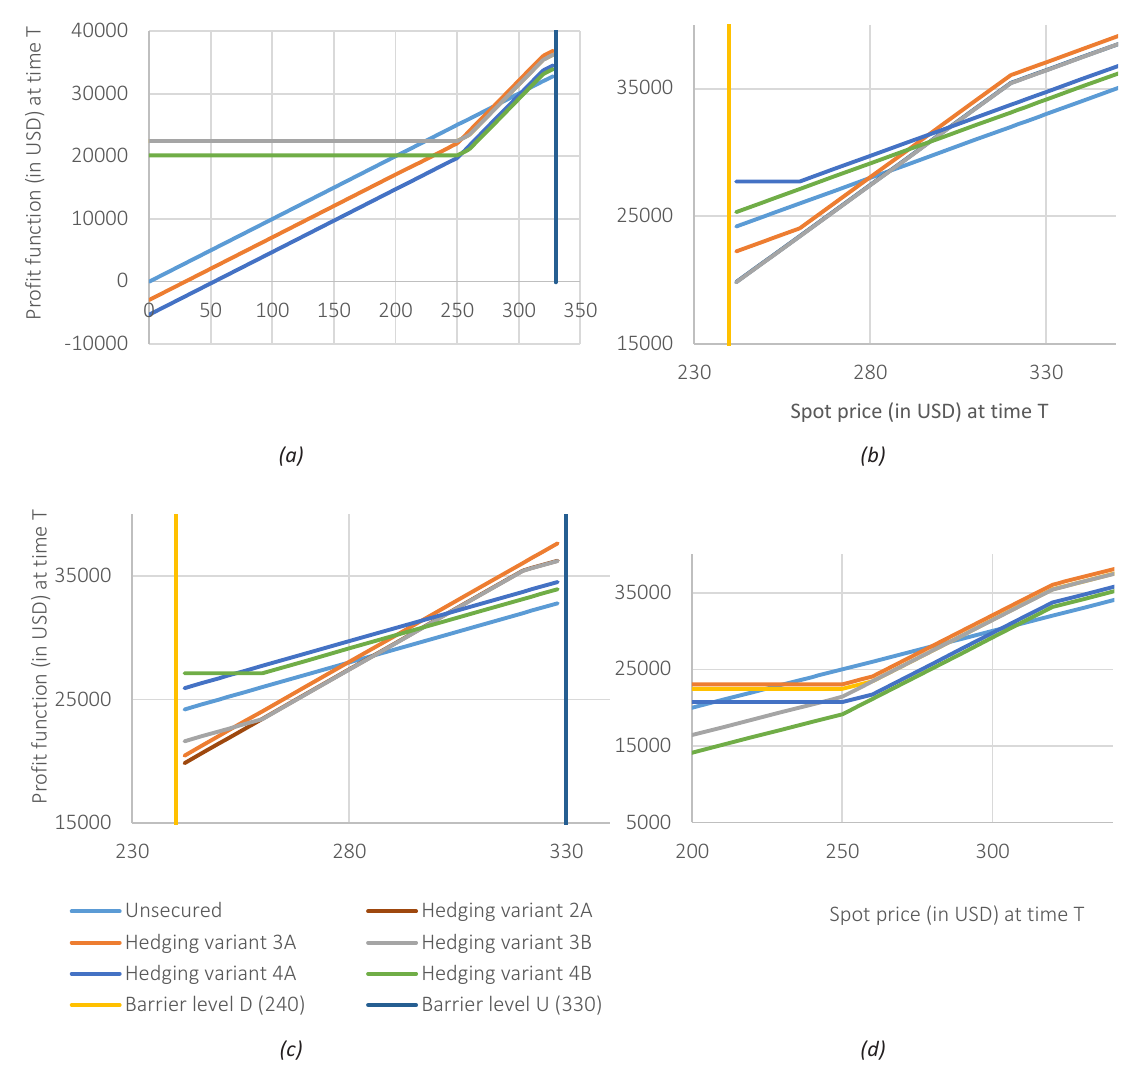
Figure 2. Comparison of the selected analyzed hedging